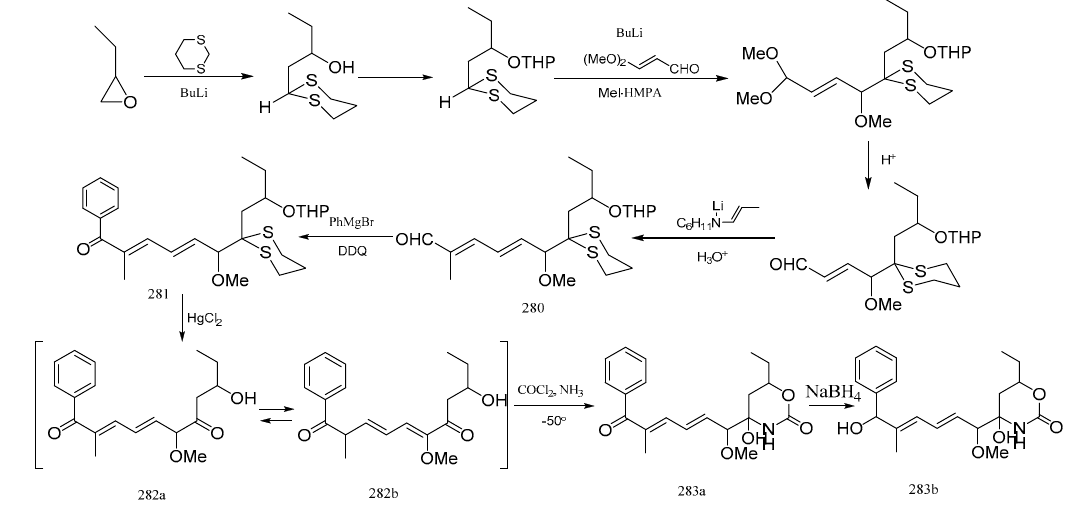
Figure 10. Some alternative synthetic by-products of the northern fragments of maytansine using two Wittig aldol condensation reactions.